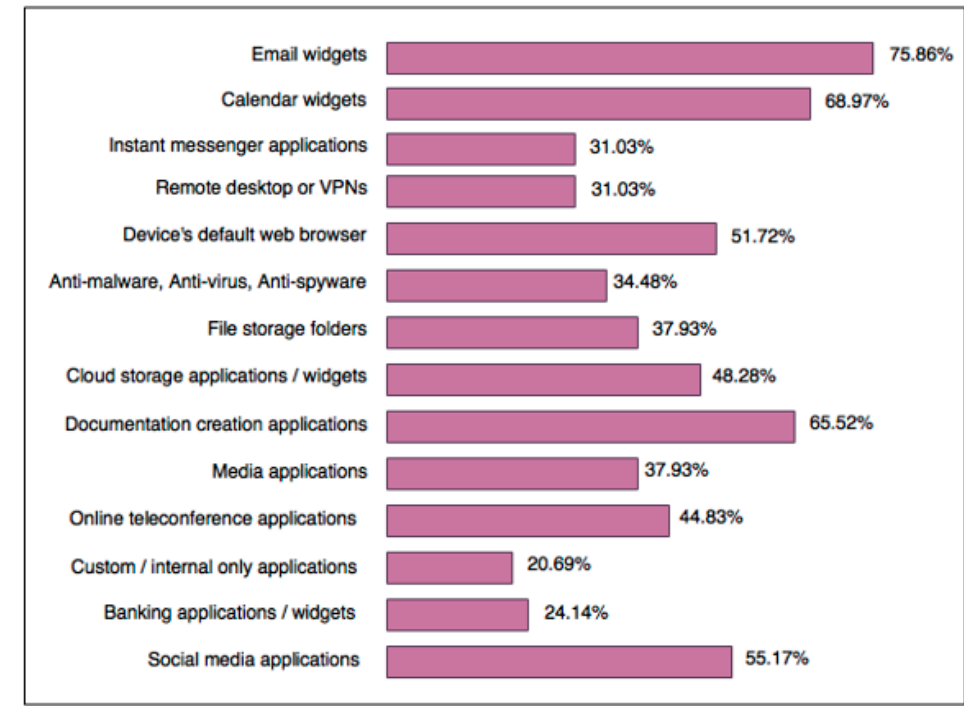
Figure 5. Applications regularly accessed via mobile devices for work purposes. In total, 86.21% of the surveyed employees use applications installed on their mobile devices for both work and personal reasons. Another 53.85% admitted to sometimes using company resources for personal reasons because BYOD made it convenient, whereas